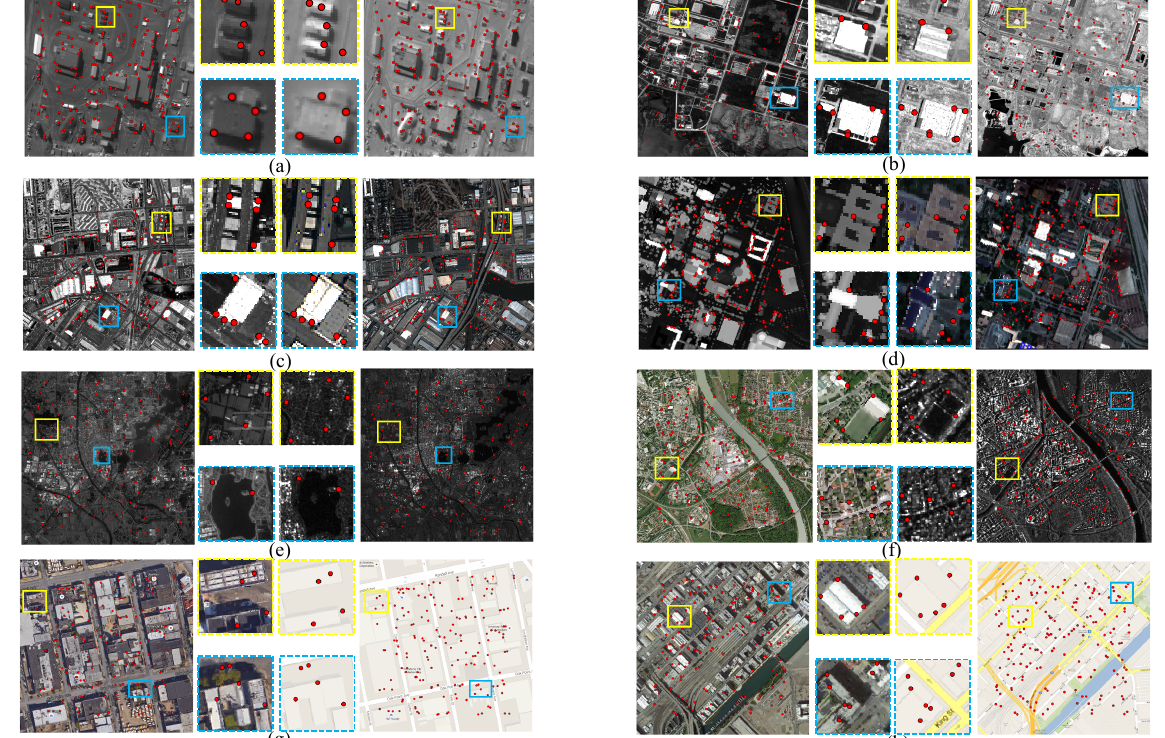
Figure 6. Matching results of all test cases by SFOC with the template size of 80 × 80 pixels. (a) Case 1. (b) Case 2. (c) Case 3. (d) Case 4. (e) Case 5. (f) Case 6. (g) Case 7. (h) Case